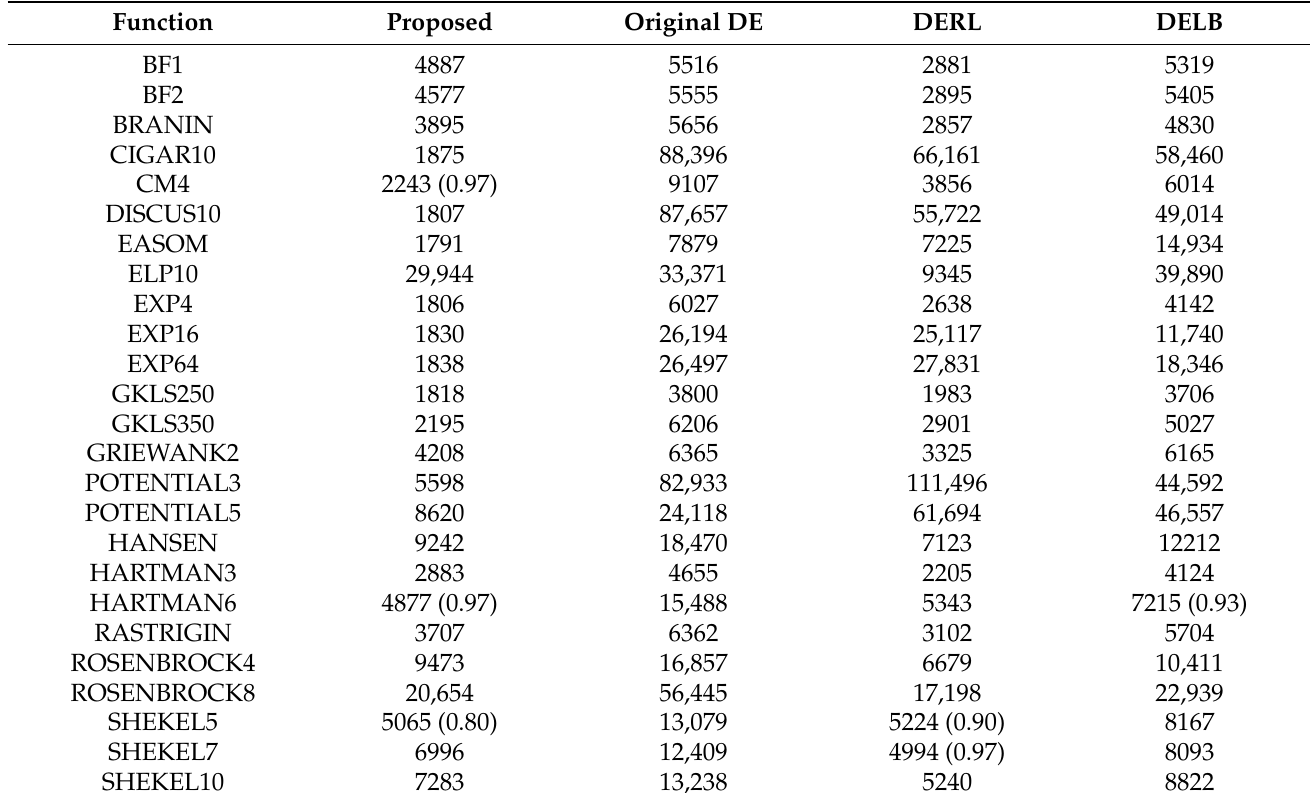
Table 4. Comparison of the proposed method against other variants of the differential evolution